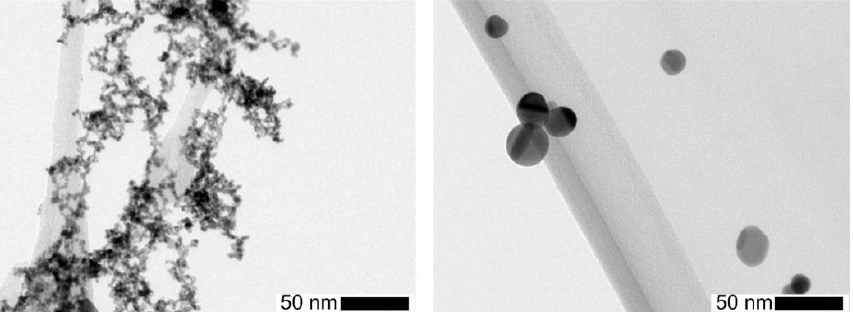
Figure 2. Effect of sintering on the morphology of platinum nanoparticles from the spark generator: ( left ) agglomerates downstream of the spark before sintering; and ( right ) spherical particles after sintering.